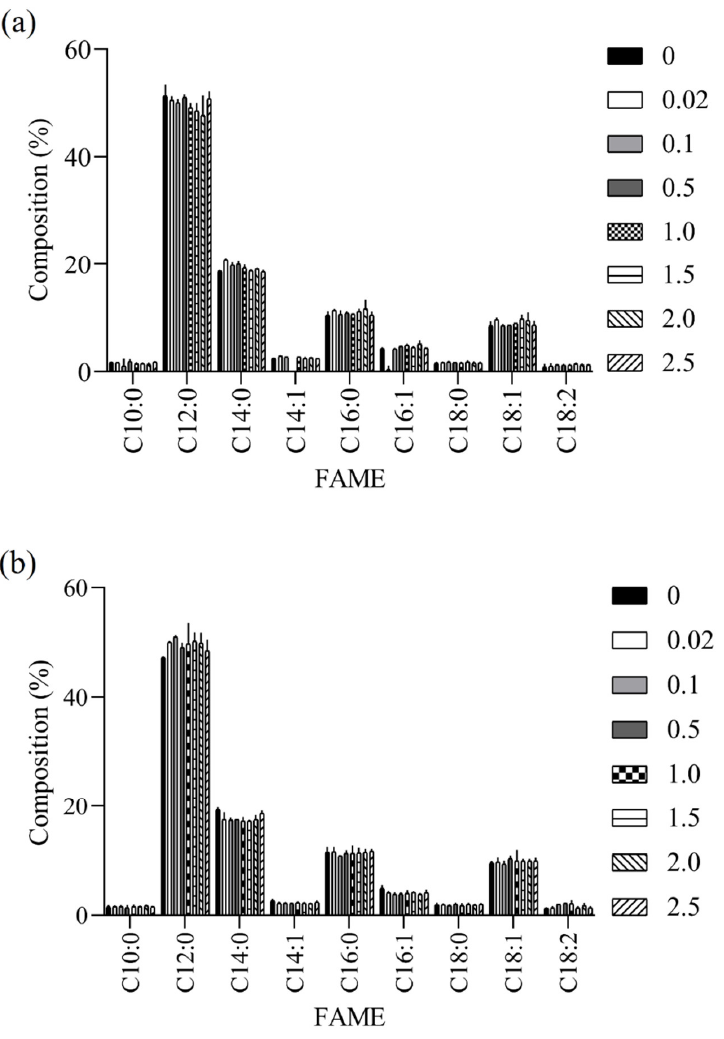
Figure 5. Fatty acid methyl ester compositions from harvested BSFL biomass feeding on in situ— ( a ) and ex situ—( b ) fermented CEW with R. oligosporus of various inoculum sizes.